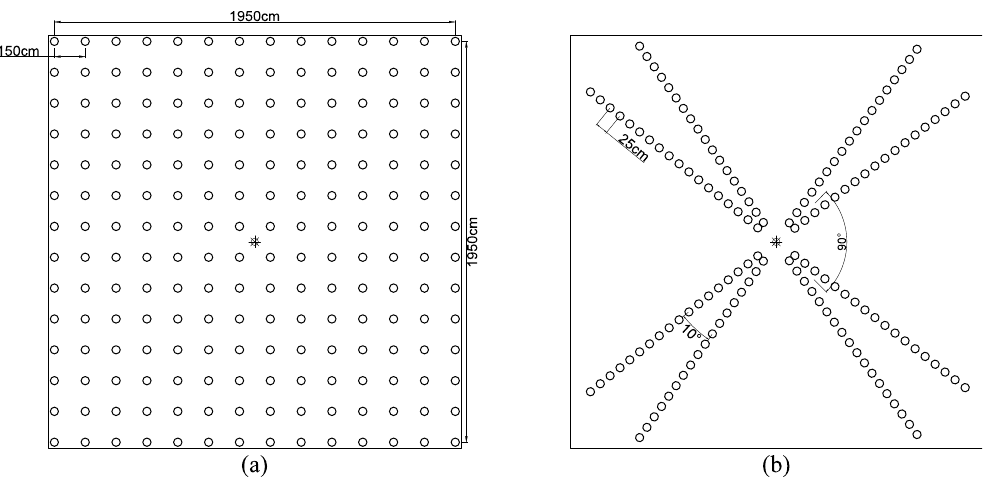
Figure 2. Catch can arrangements for measurements of water distribution with rotating ( a ) and fixed ( b ) spray plate sprinklers. Asterisks indicate the locations of sprinklers.